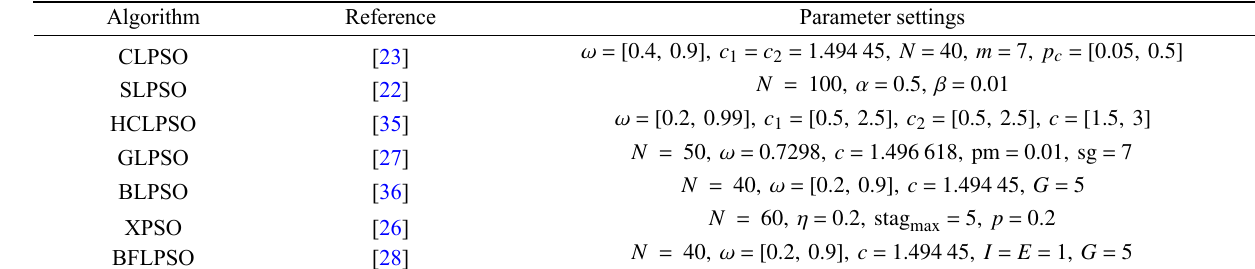
Table 1 Parameter settings of all the contrasted